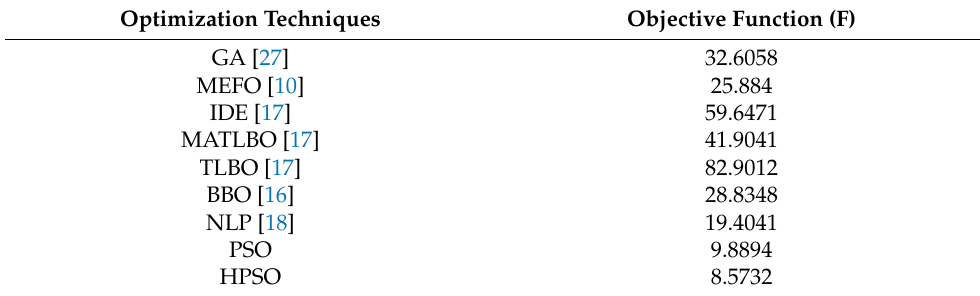
Table 4. Comparison of PSO and HPSO with other techniques.